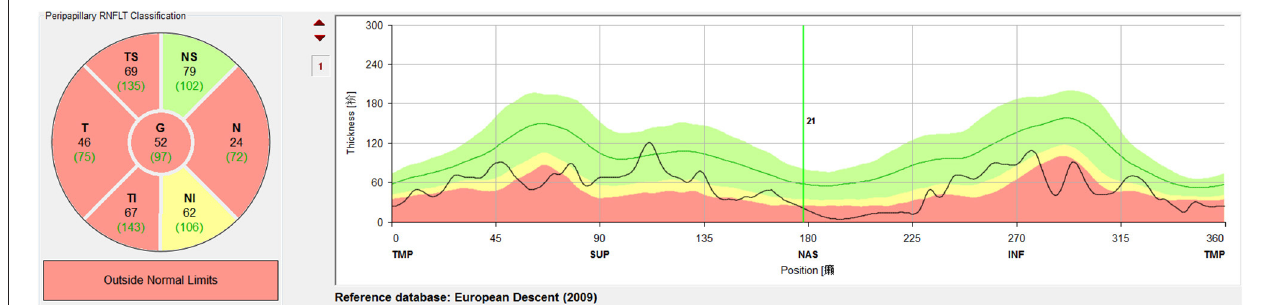
FIGURE 2 | Measurement and regionalized of the retinal nerve fiber layer thickness (RNFLT) were demonstrated. A circular scan with a 3.4mm diameter centered on the optic nerve head was performed through undilated pupils with the Spectralis OCT + HRA system. The average parapapillary RNFLT(G) and the average RNFLTs in the T (315 ◦ -45 ◦ ), TS (45 ◦ -90 ◦ ), and TI (270 ◦ -315 ◦ ) sectors were obtained with the Spectralis viewing software (Heidelberg Eye Explorer, version 1.0.10.0).